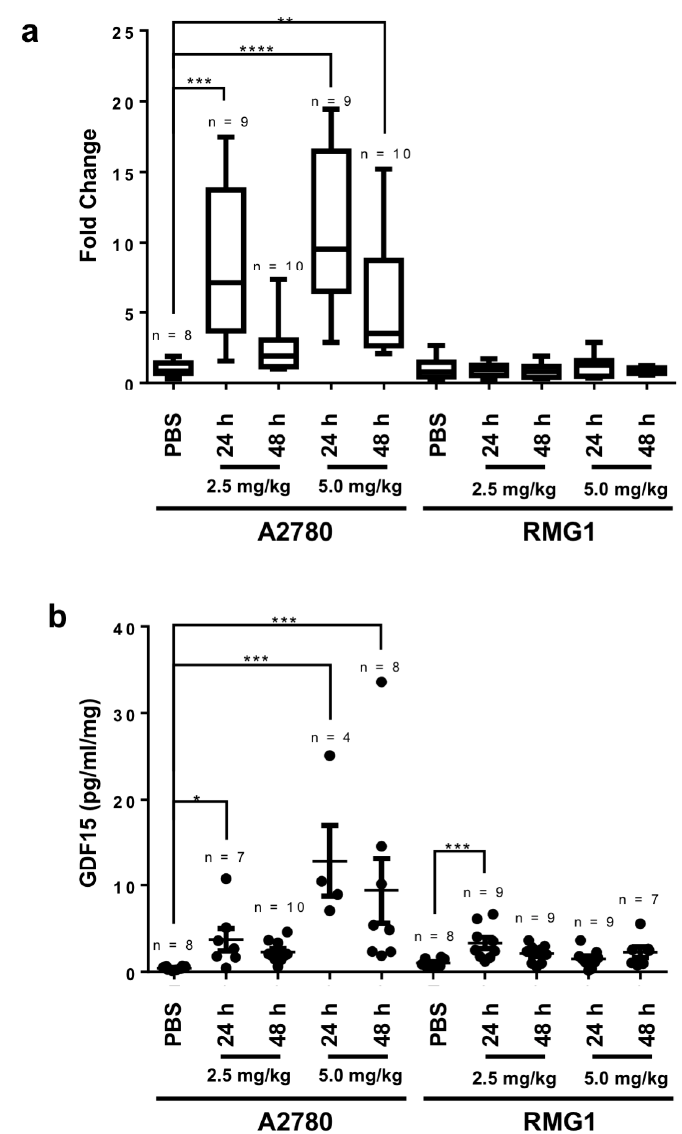
Figure 4. Induction of GDF15 expression in mouse ovarian tumors and sera by cisplatin treatment in vivo: ( a ) Semiquantitative RT-PCR analysis of GDF15 expression performed using total RNA extracted from mouse A2780 (cisplatin-sensitive) and RMG1 (cisplatin-resistant) tumors after treatment with cisplatin (2.5 or 5 mg / kg) for 24 or 48 h. ** p = 0.004; *** p = 0.0007; **** p < 0.0001; ( b ) Enzyme-linked immunosorbent assay of GDF15 sera levels in mice. * p = 0.03; *** p =